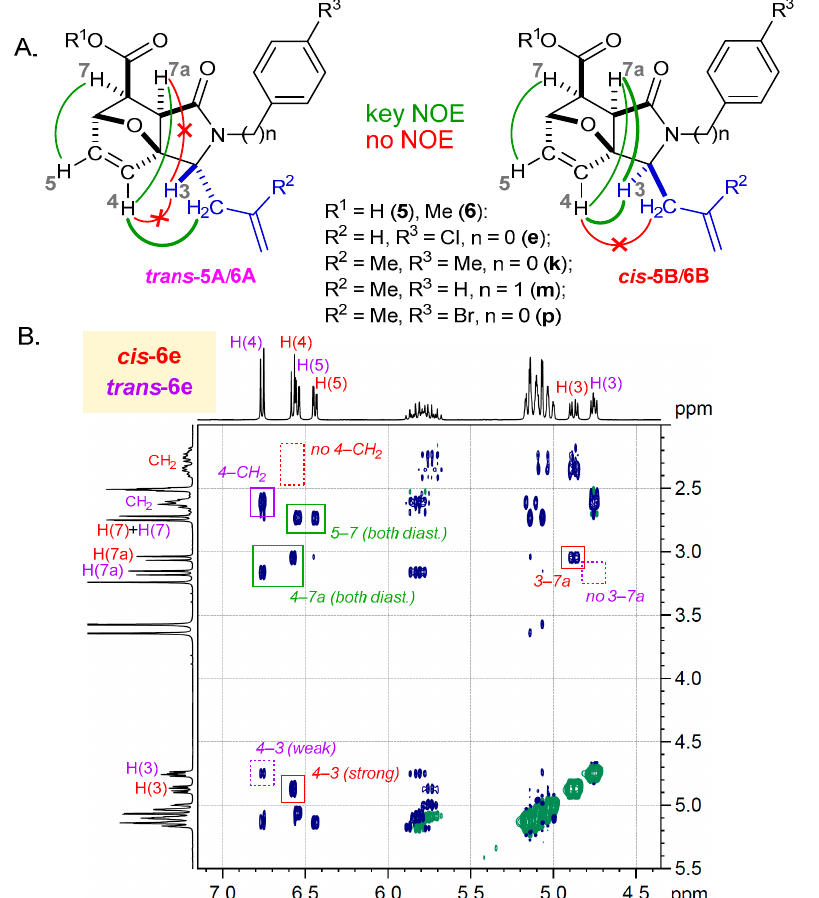
Figure 4. ( A .) Key observed NOE interactions in 2D NOESY NMR spectra for both representative trans - and cis -diastereomers 5e , k , m , p and 6e , k , m , p ( A / B ). ( B .) Representative part of 2D NOESY spectra for mixture of trans - (violet) and cis - (red) diastereomers of the allyl derivative 6e with assignments of signals and NOE.